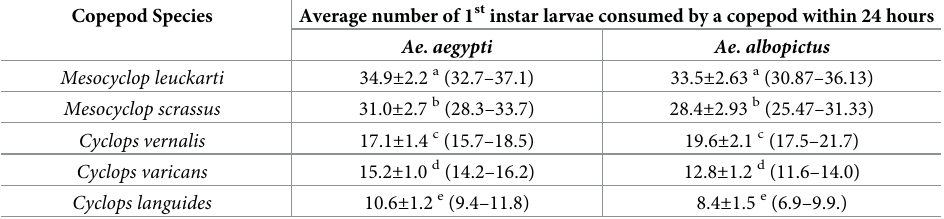
Note: Values are Mean ± SE, range in parenthesis. Different superscript letters (from a to e) in a column show significant differences (p < 0.05) as suggested by General Linear Modelling followed by the Tukey’s pair wise comparison at 95% level of